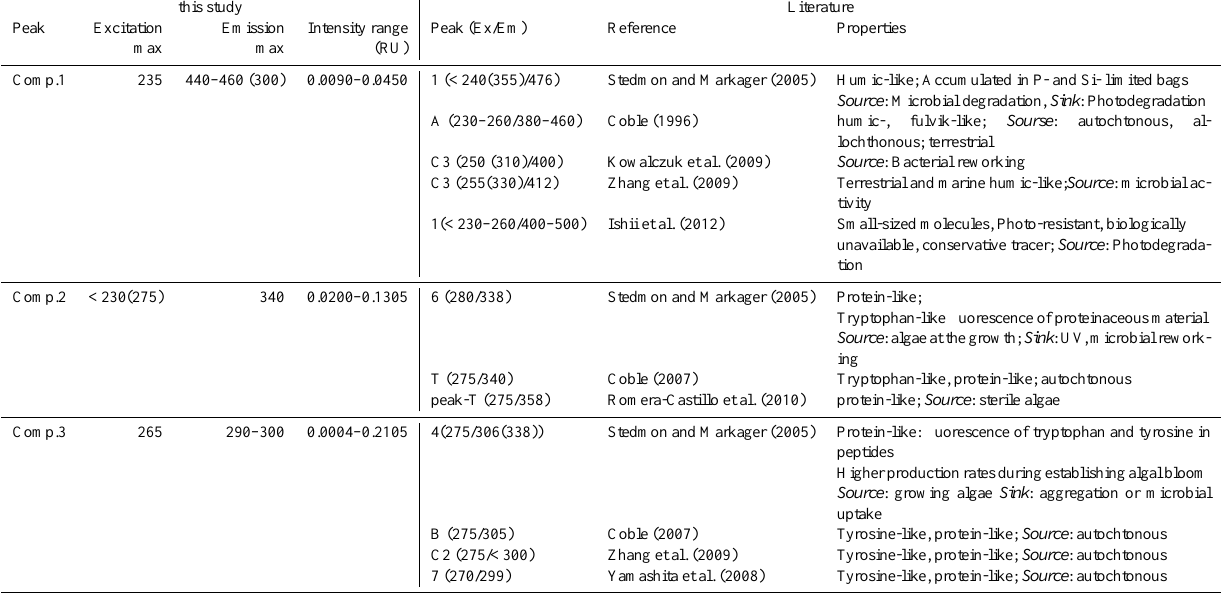
Table 3. Spectral characteristics of excitation and emission maxima and range of intensities of the three fluorescent components identified by PARAFAC modeling in this study and their comparison with previously reported